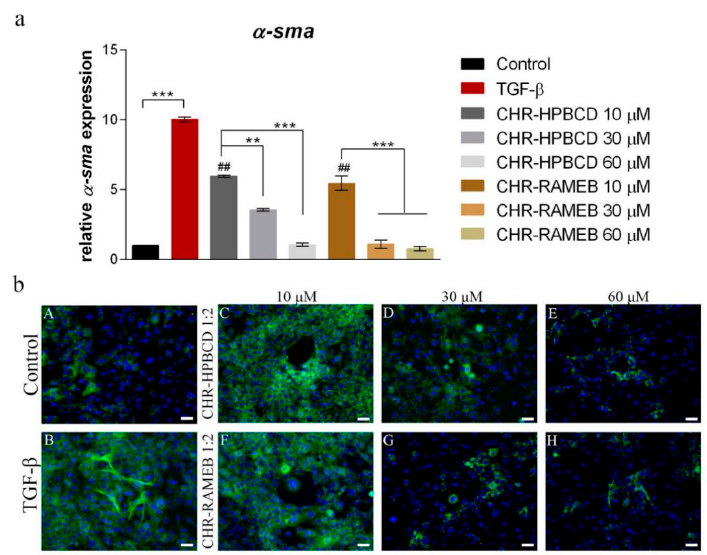
Figure 6. Evaluation of α -sma expression in HSCs after 48 h exposure to CHR complexed with RAMEB and HPBCD (1:2). ( a ) Relative gene expression of α -sma in HSCs. Statistical significance: ** p < 0.01; *** p < 0.001; ## p < 0.01 (CHR–RAMEB / CHR–HPBCD vs. TGF- β ); ( b ) Immunofluorescence staining of α -sma (antibody conjugated with FITC, green), nuclei of the cells stained with Hoechst 33,342 (blue),